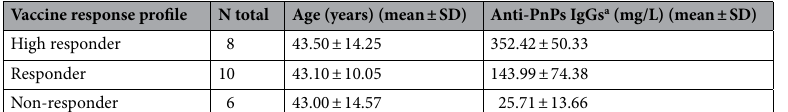
Table 1. Demographic characteristics of subjects included in the groups of study, classified according to their PCV13 response profile as determined by ELISA. SD Standard deviation. a Determined by